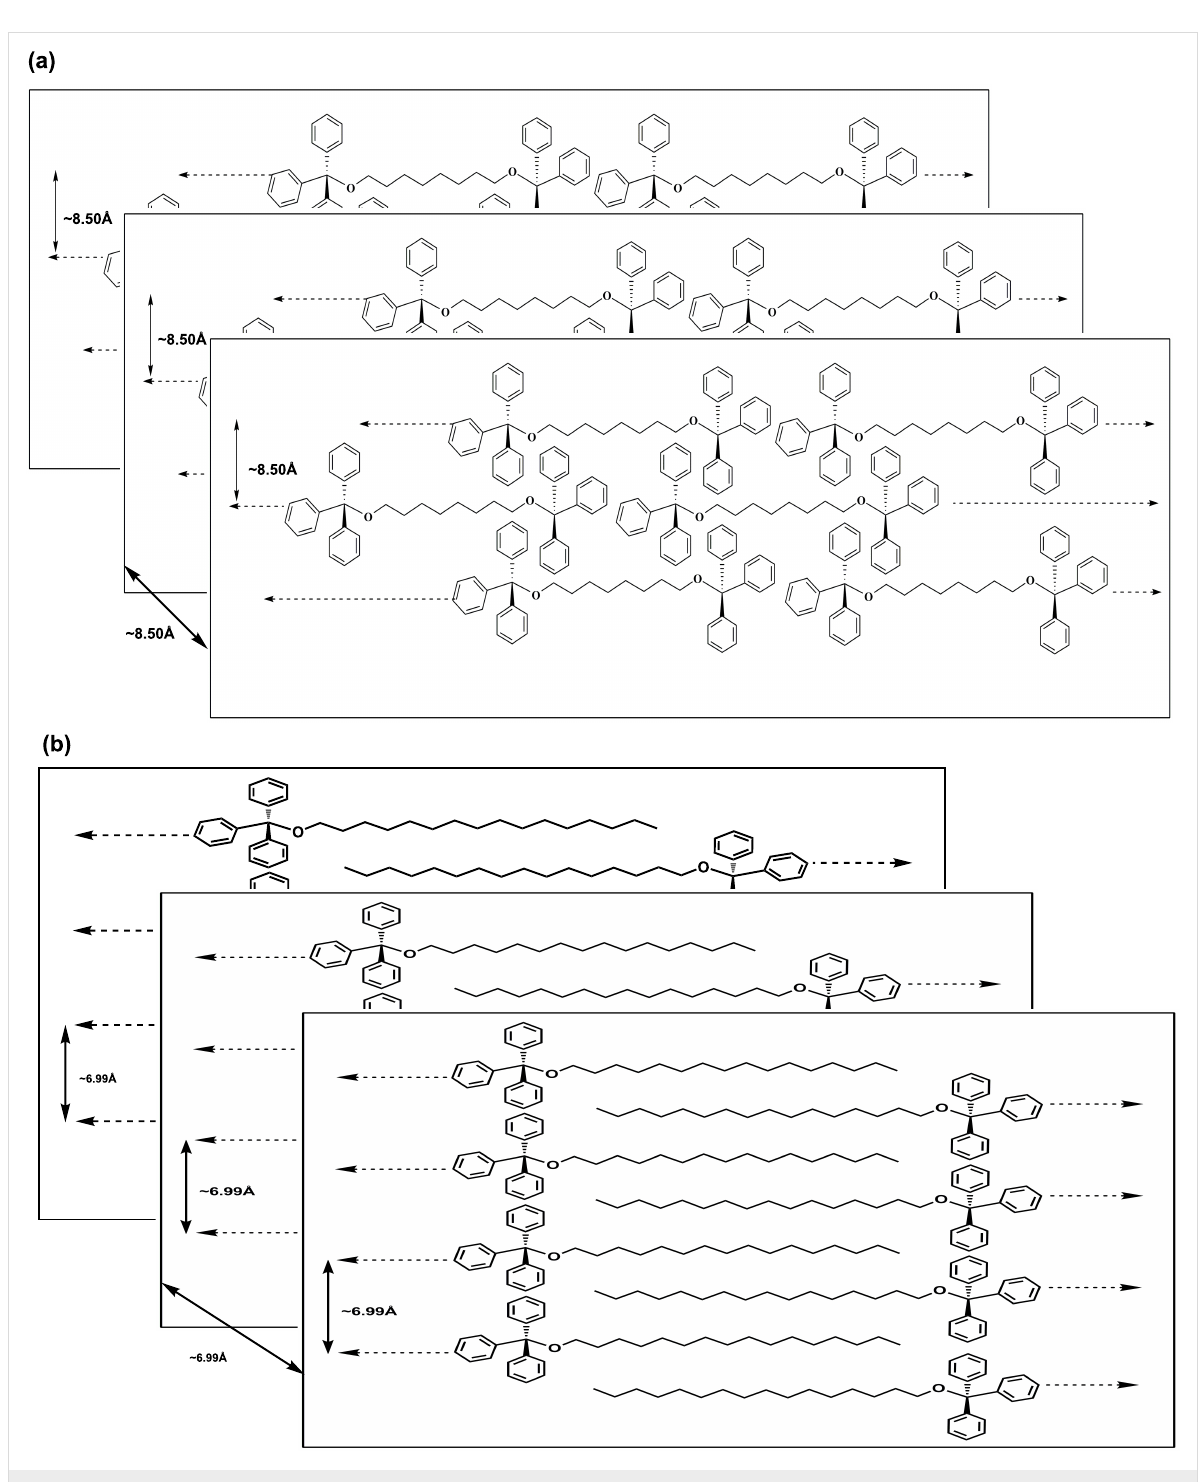
Figure 9: Possible molecular packing arrangement in the self-assembled gel state of (a) TPM-G12 and (b) TPM-G5 .